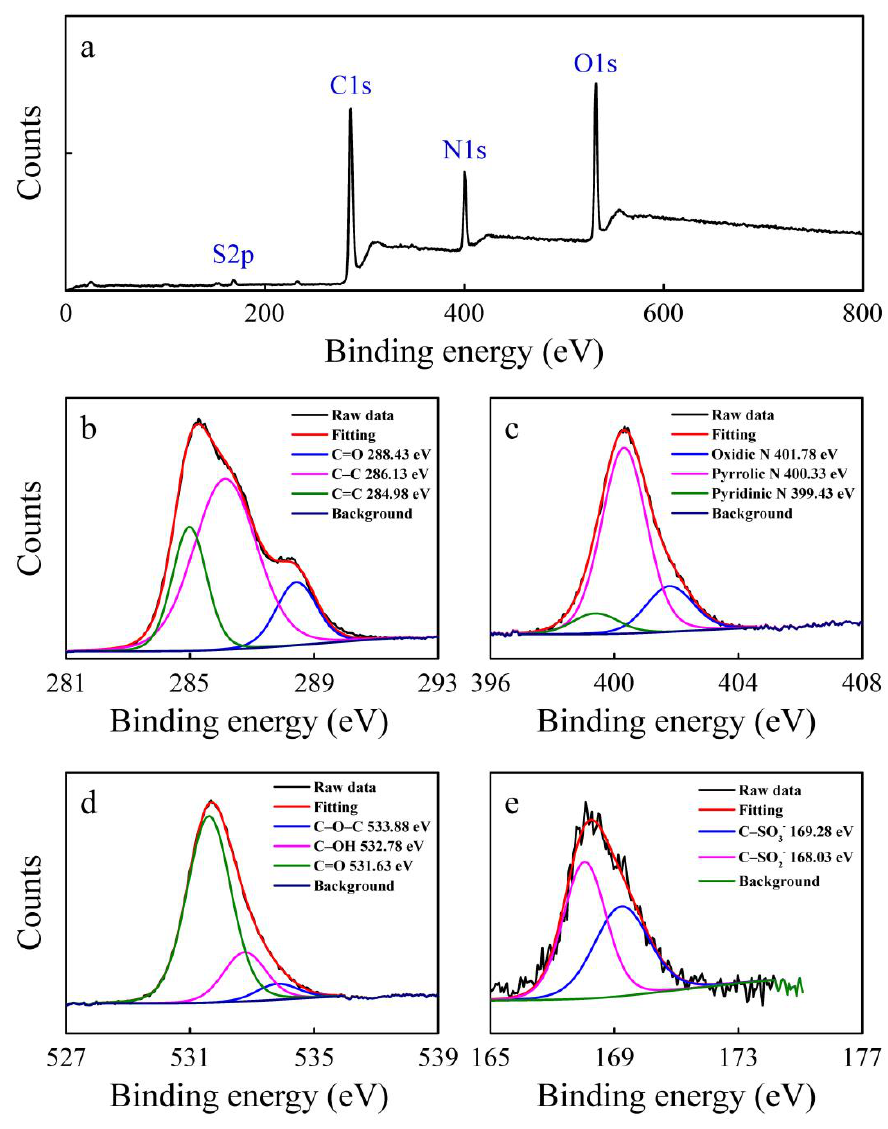
Figure 2. ( a ) XPS full survey spectra of the NSCDs. High-resolution XPS spectra of ( b ) C1s, ( c ) N1s, ( d ) O1s, and ( e ) S2p of the